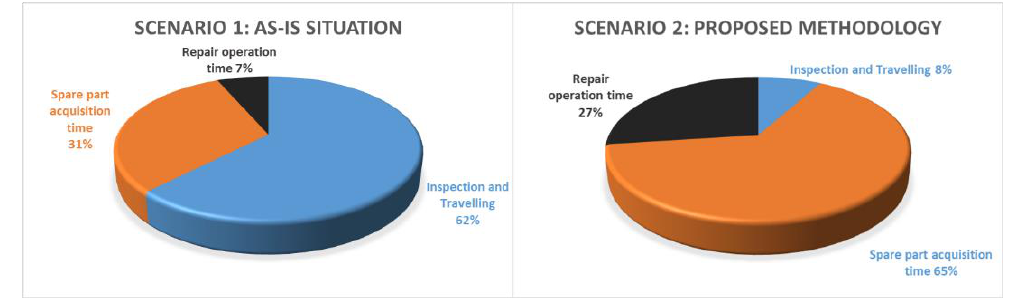
Figure 9. Distribution of time AS-IS situation vs. Proposed Methodology.